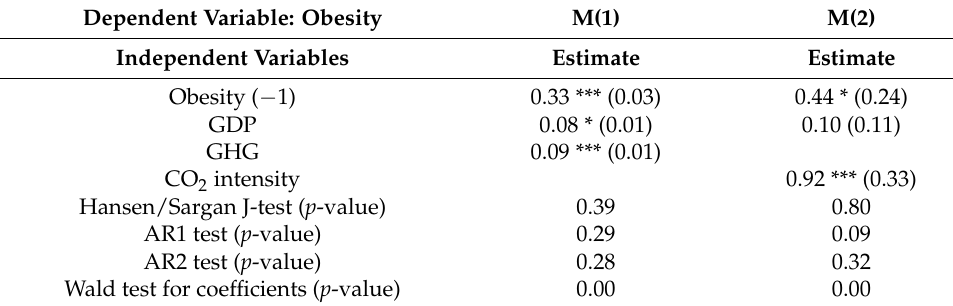
Table 5. One-step system GMM